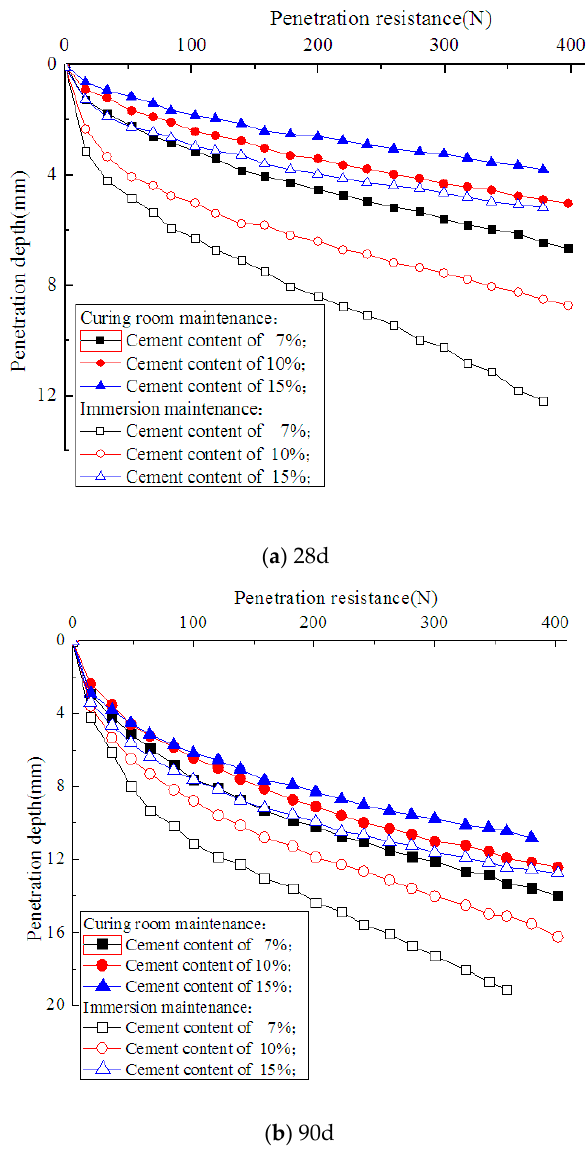
Figure 5. Penetration resistance-depth curves.